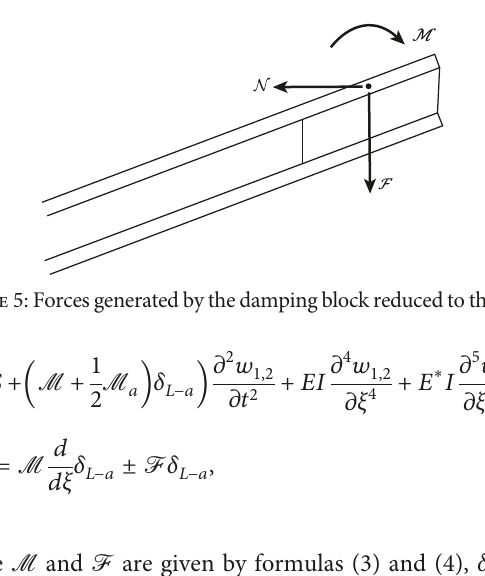
Figure 4: Double-beam structure with embedded intelligent damping MRE element.